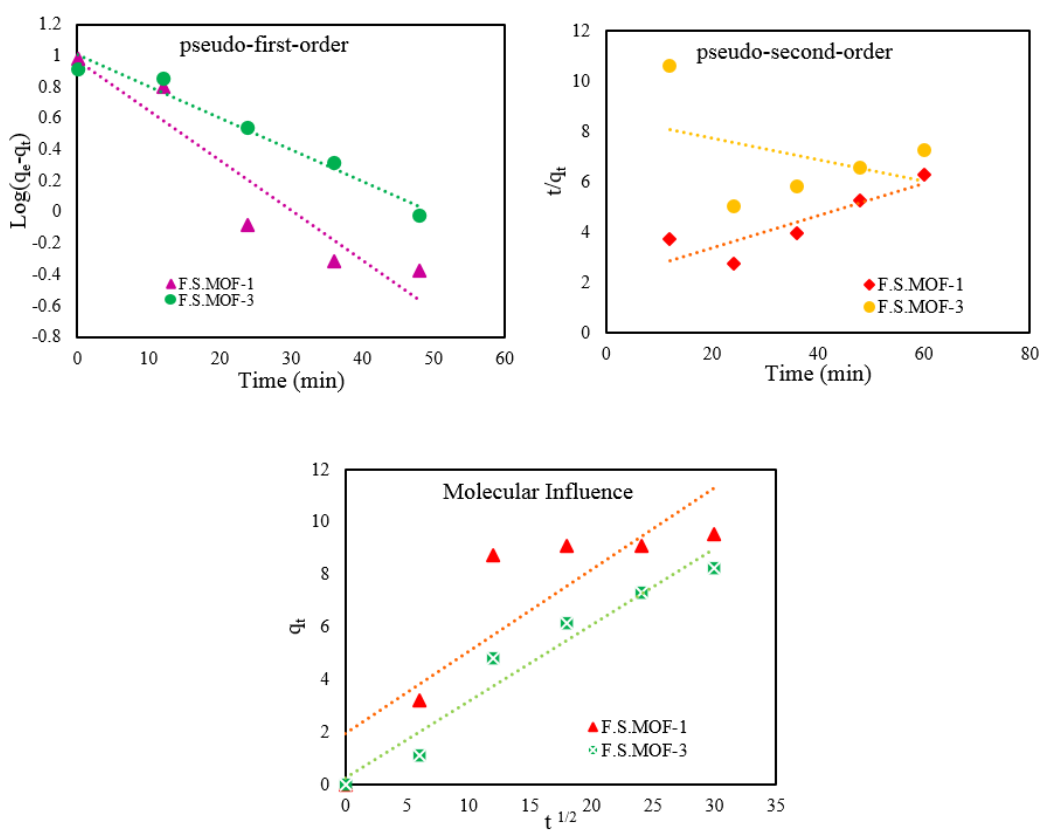
Fig. 17. Examination of different kinetic types for methylene blue degradation with different nanocomposites a) The pseudo-first-order kinetics b) pseudo-second-order kinetic c) kinetic of intramolecular penetration